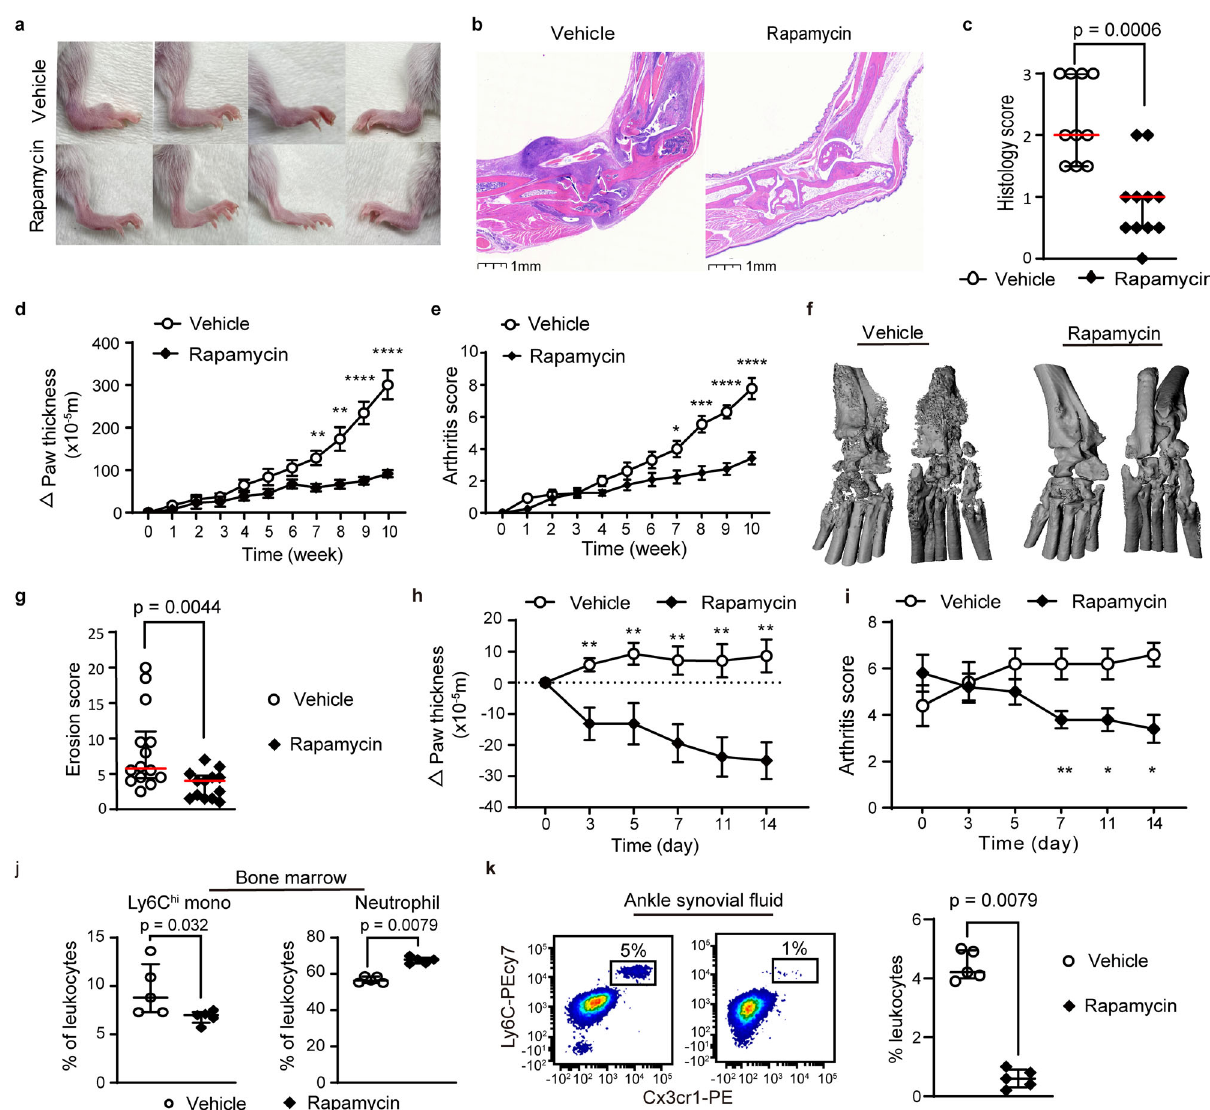
Fig. 3 | Rapamycin treatment reduces arthritis severity and bone erosion in IL1rn − / − mice. a Representative depiction of ankle in fl ammation, ( b ) hematoxylin andeosinstainingofanklesections,( c )histologicscoresofanklearthritis(vehicle, n =10; rapamycin n =11), ( d ) ankle and wrist thickness (vehicle, n =14; rapamycin n =11), ( e ) composite arthritis score (vehicle, n =14; rapamycin n =11) and ( f , g ) micro-CT quanti fi cation of joint erosion in IL1rn − / − mice treated with rapamycin or vehiclefor10weeks. h Ankleandwristjointmeasurements( n =8pergroup)and( i ) compositearthritisscore( n =5pergroup)inIL1rn − / − micewithestablishedarthritis treated with vehicle or rapamycin for 2 weeks. j Flow cytometry quanti fi cation of